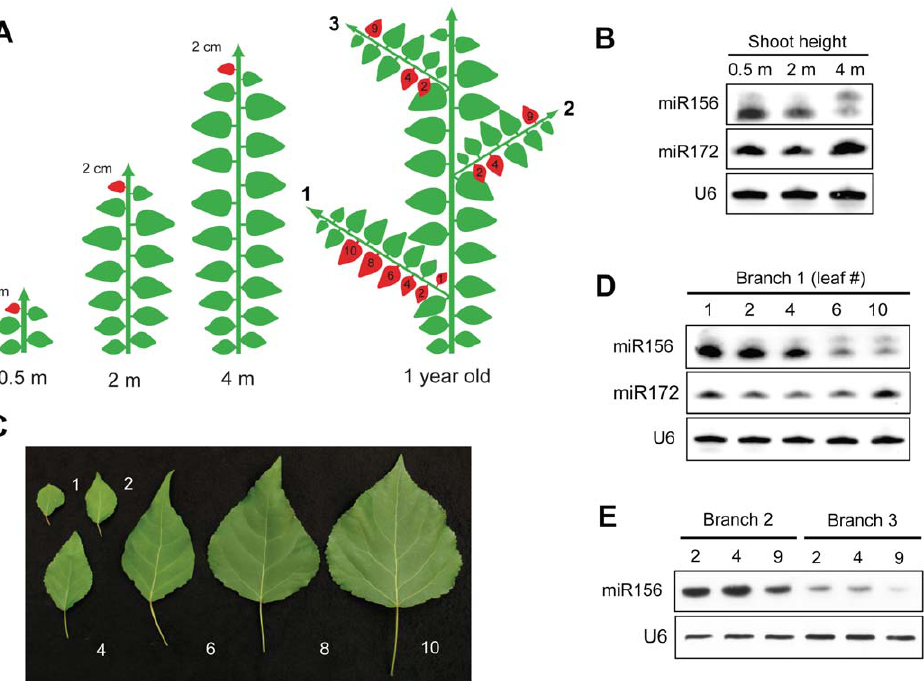
Figure 3. Spatial expression pattern of miR156 in P.xcanadensis . (A) Diagram illustrating the source of the leaf samples analyzed in 3B–3E. 2 cm leaf primordia were harvested from the shoot apex of 0.5 m, 2 m and 4 m tall shoots; fully expanded leaves were harvested from a branch (branch 1) of a 6 month-old tree, and 2 cm leaves or leaf primordia were harvested from branches located 2.5 m (branch 2) and 4 m (branch 3) from the base of a 1-year-old tree. Drawing is not to scale. (B) miRNA expression in 2 cm long leaf primordia from the shoot apices of trees of different heights. (C) Fully-expanded leaves from a single branch of a 6-month-old tree, numbered from the closest position to the trunk. (D) miRNA expression in the leaves illustrated in (C). (E) miR156 expression in 2 cm leaves or leaf primordia on branches located 2.5 m (branch 2), and 4 m (branch 3) from the base of the shoot.